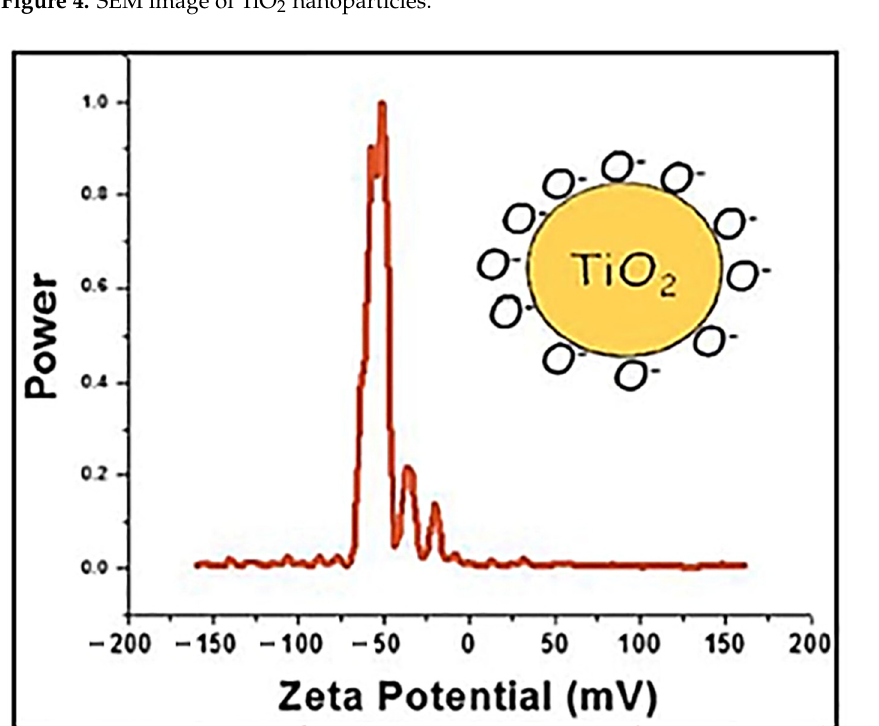
Figure 4. SEM image of TiO 2 nanoparticles.